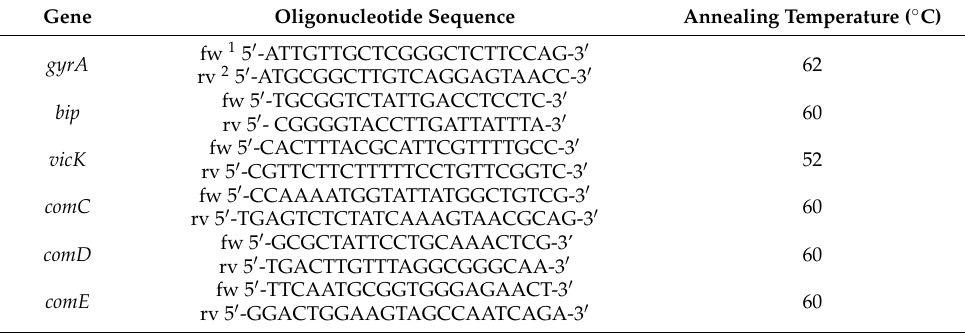
Table 3. Sequences of the oligonucleotides used in the qRT-PCR experiments.